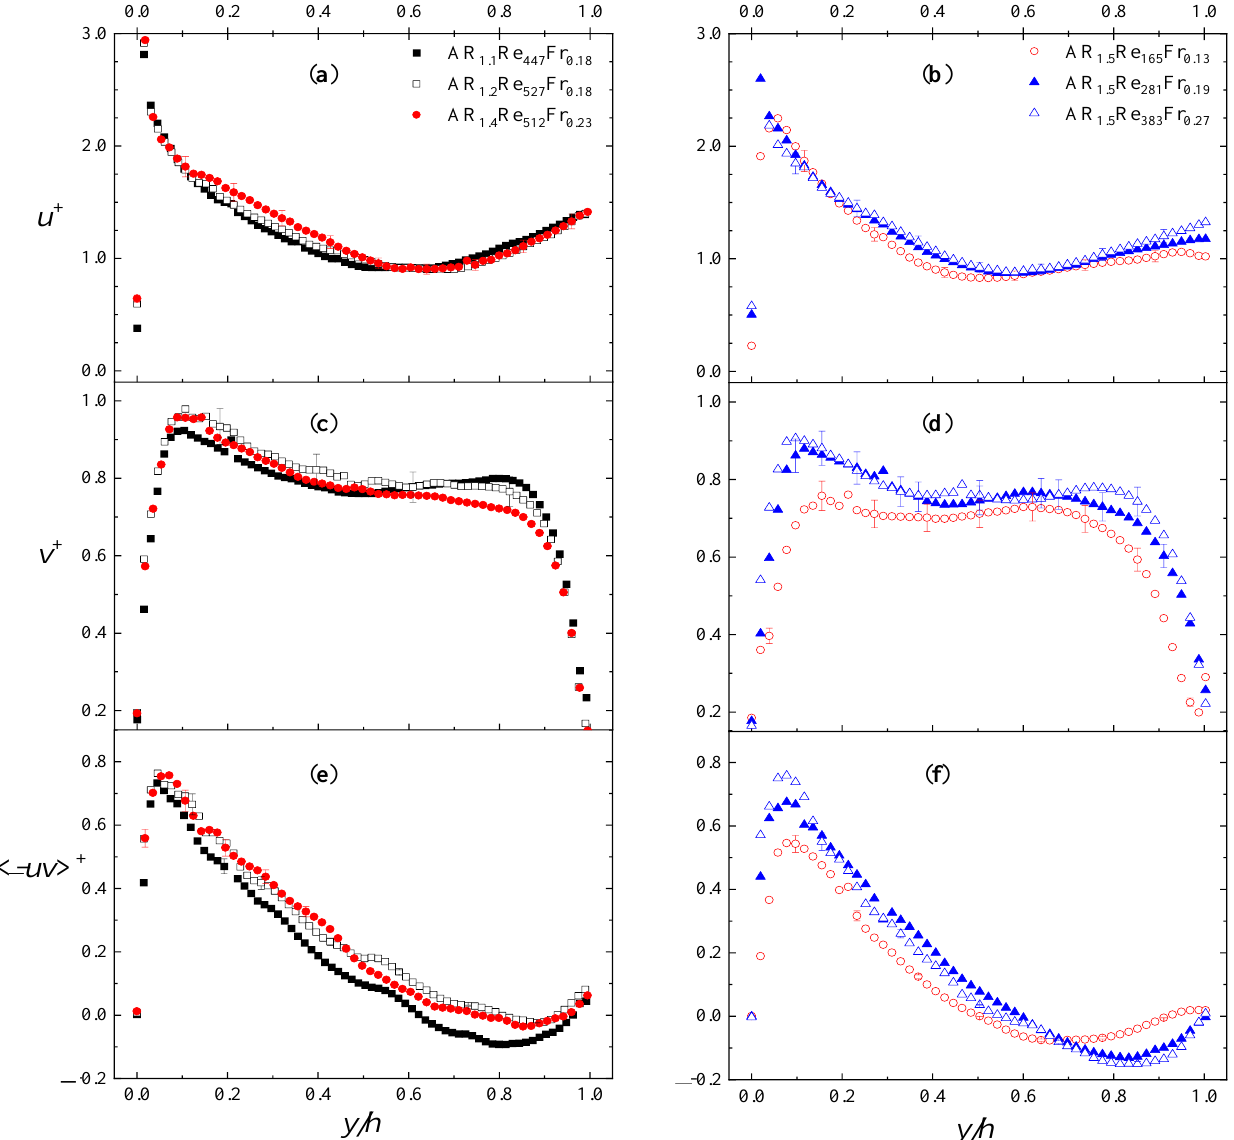
Figure 9. Variations of normalized streamwise turbulence intensity u + ( a,b ), wall-normal turbulence intensity v + ( c,d ), and Reynolds shear stress <− uv + > ( e , f ), with the normalized wall-normal location y / h . This is conducted for selected test conditions to highlight effects of AR ( a,c,e , using the same legend) and Re 𝜃 ( b,d,f using the same legend).